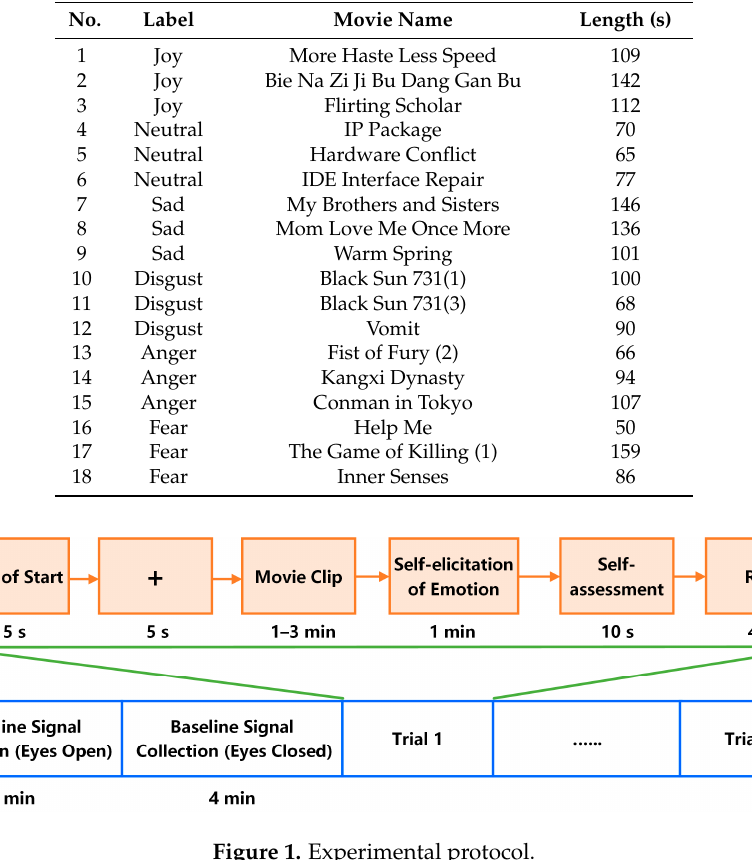
Figure 1. Experimental protocol.